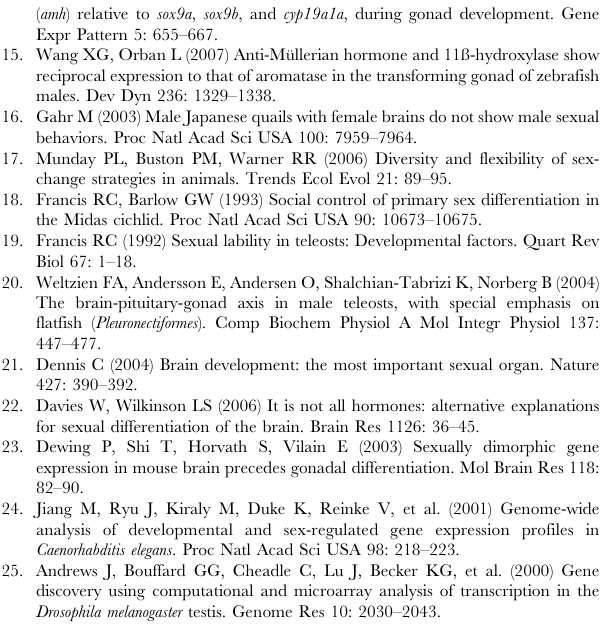
Table S8 List of 183 gonad-expressed genes that show female brain-enhanced expression. These genes i)show at least 1.5-fold higher expression than the common reference in the female brain and one or both gonads; and ii) are differentially expressed (at least 1.5-fold) both between the gonads and between the brains of the two sexes. Normalized intensities (‘Norm’) and corresponding standard errors (‘StdErr Norm’) are shown, along with the ratios of normalized intensities of female brain:male brain (‘Ratio FB/MB’) and ovary:testis (‘Ratio FO/MT’). (FB, FO, FK, FRB: brain, ovary, kidney, ‘rest-of-body’ from female zebrafish; MB, MT, MK,